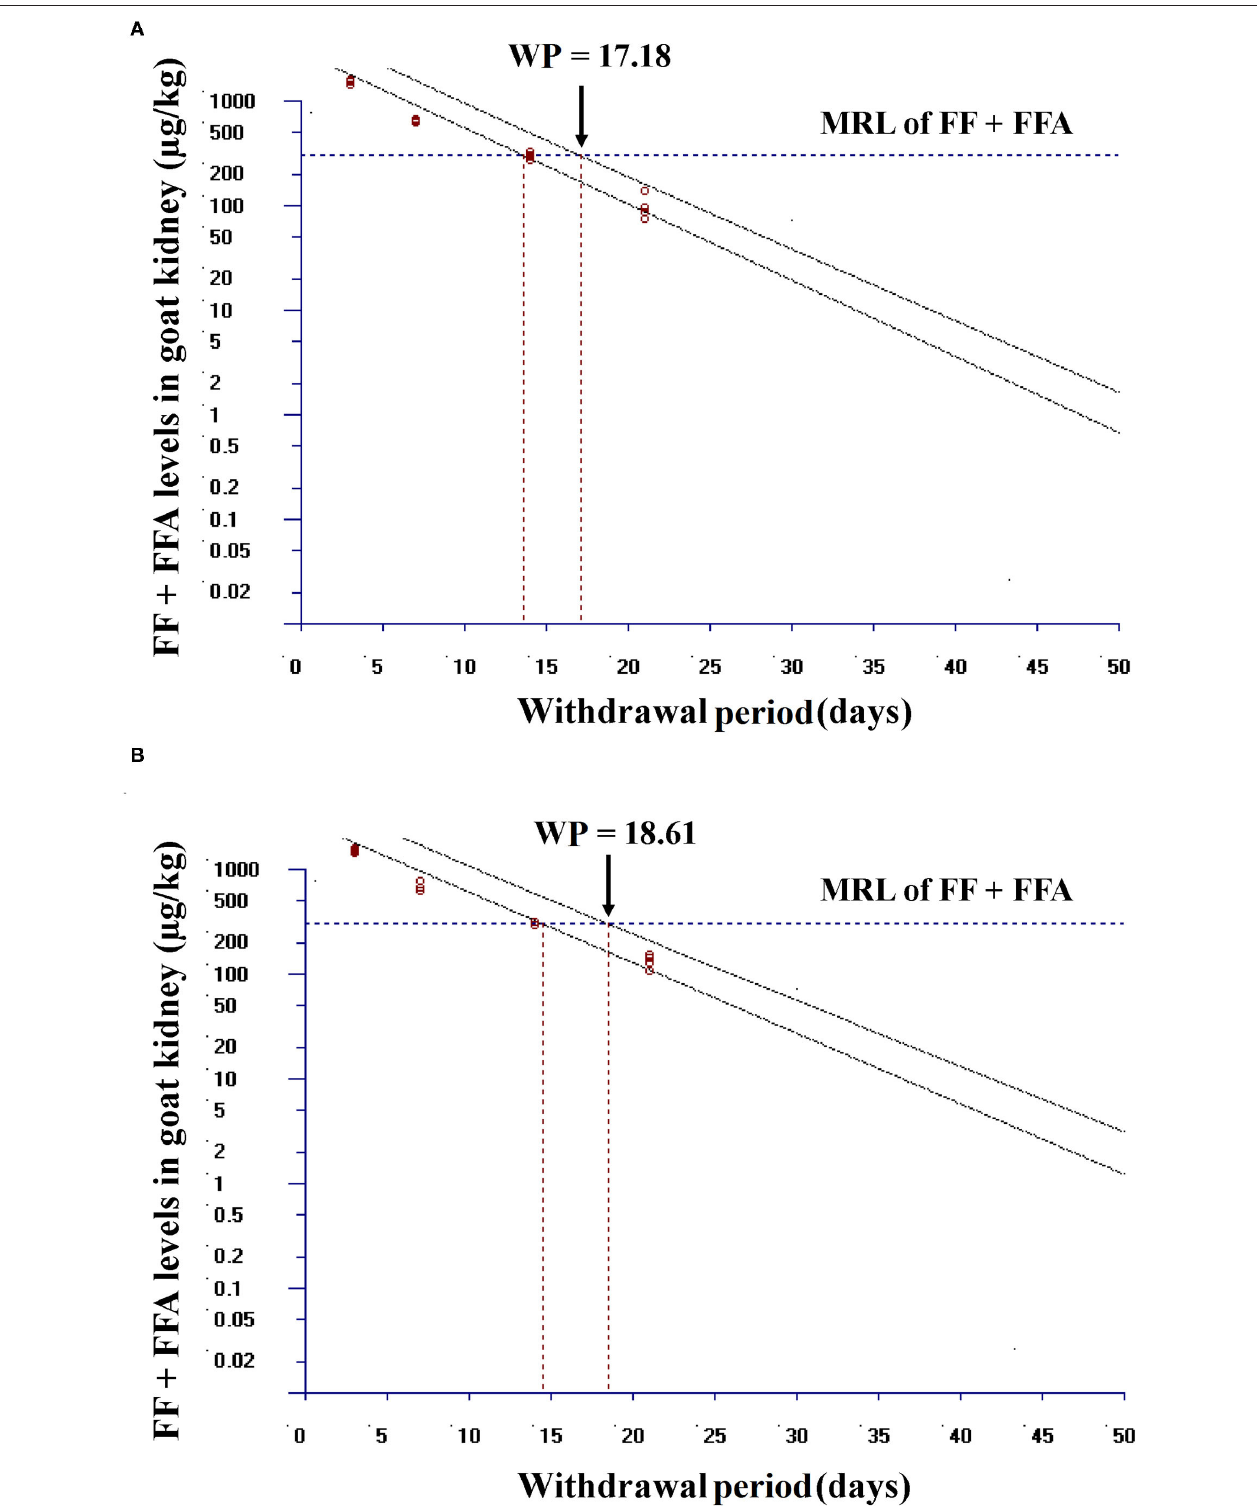
FIGURE 8 | Plot of the withdrawal period calculation for FF in goat kidney at the time when the one-sided 95% upper tolerance limit is below the EU MRL for FF (300 µ g/kg). (A) In single group, after intramuscular administration of FF (20mg FF/kg bw, at 48h intervals, twice in total) and (B) in combined group, after intramuscular administration of FF (20mg FF/kg bw, at 48h intervals, twice in total) plus DOX (10mg DOX/kg bw, once a day for 3 days). Residue marker is the sum of florfenicol (FF) and its metabolite florfenicol-amine (FFA).